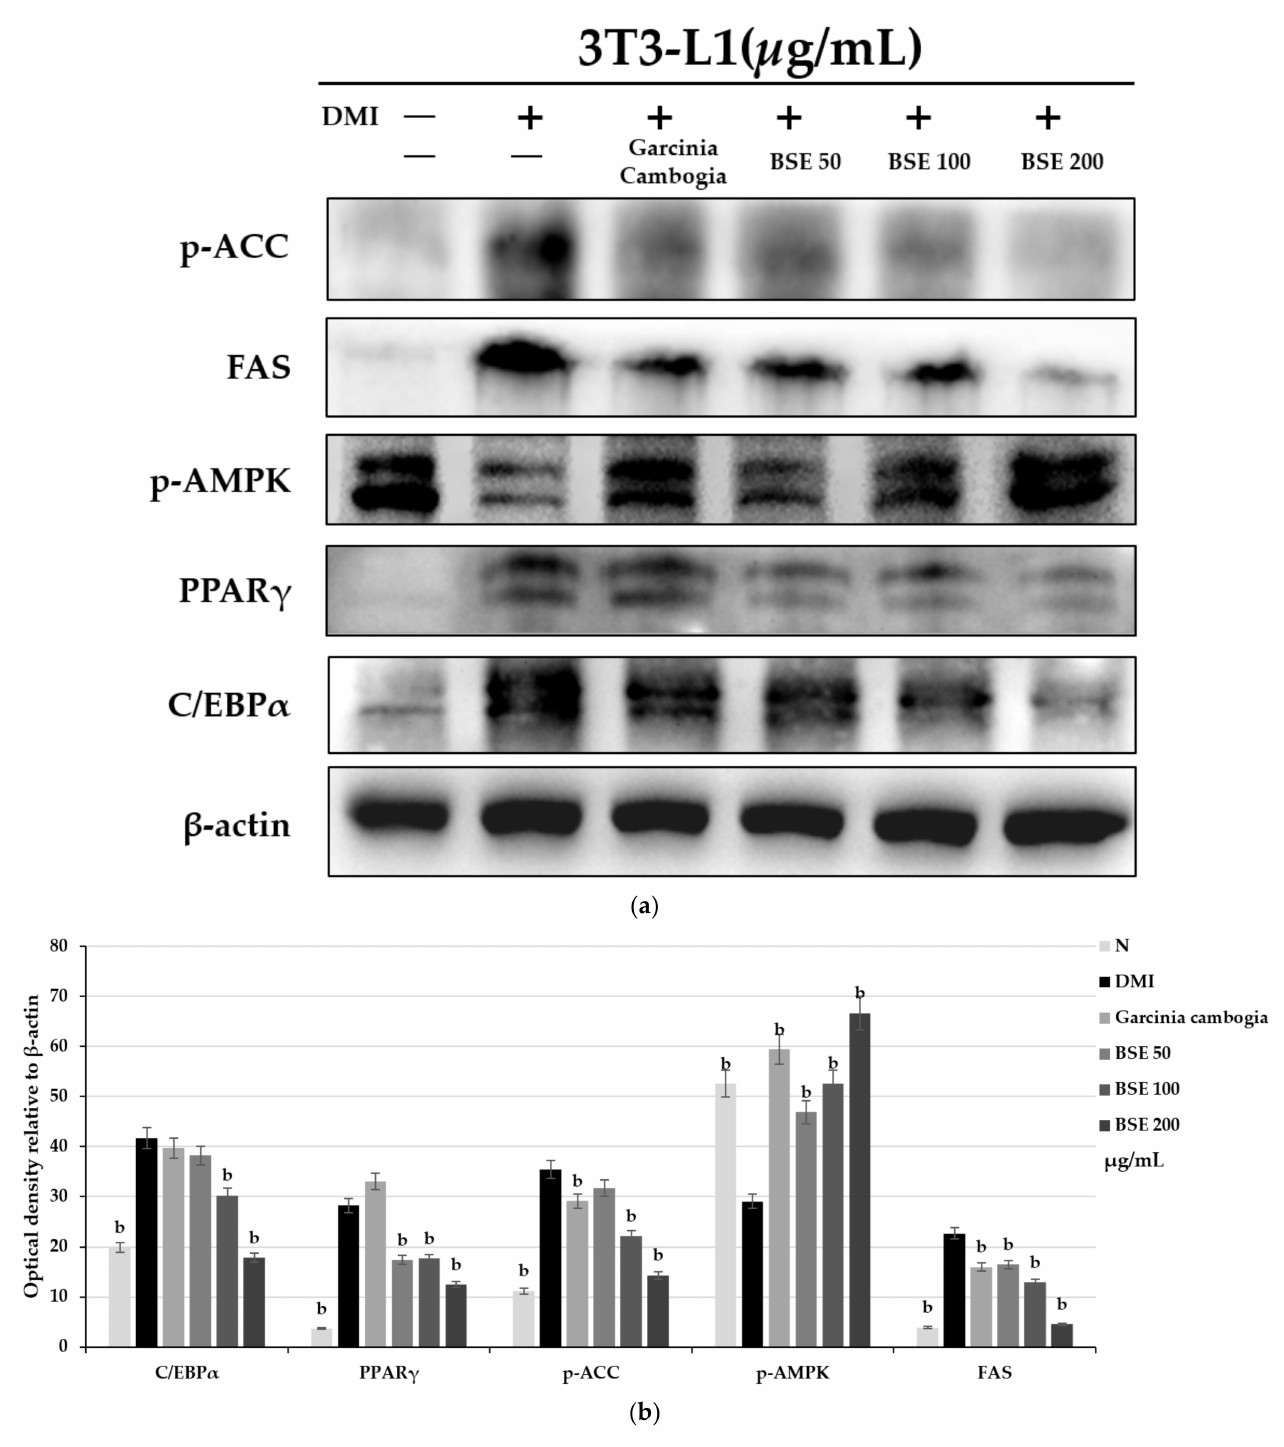
Figure 3. Changes in 3T3-L1 intracellular protein expression caused by hot-water barley sprout extract (BSE). ( a ) Western blotting and ( b ) semi-quantitative analysis. Statistical analysis was performed using a t -test. b p < 0.01 compared with group DMI. p-ACC, phospho-acetyl-CoA carboxylase; FAS, fatty acid synthase; p-AMPK, phospho-AMP-activated protein kinase; PPAR γ , peroxisome proliferator-activated receptor gamma; C/EBP α , CCAAT/enhancer-binding protein